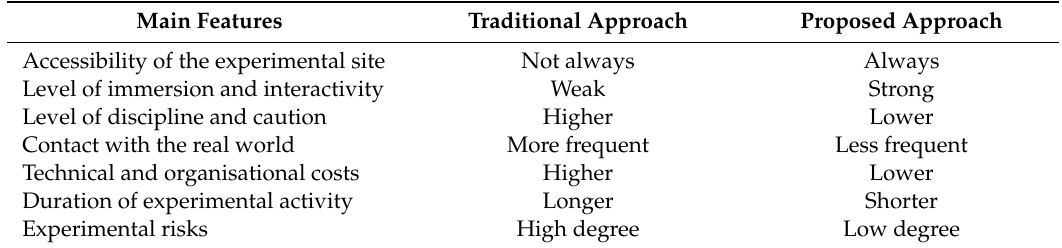
Table 3. Comparison between the proposed approach and the traditional